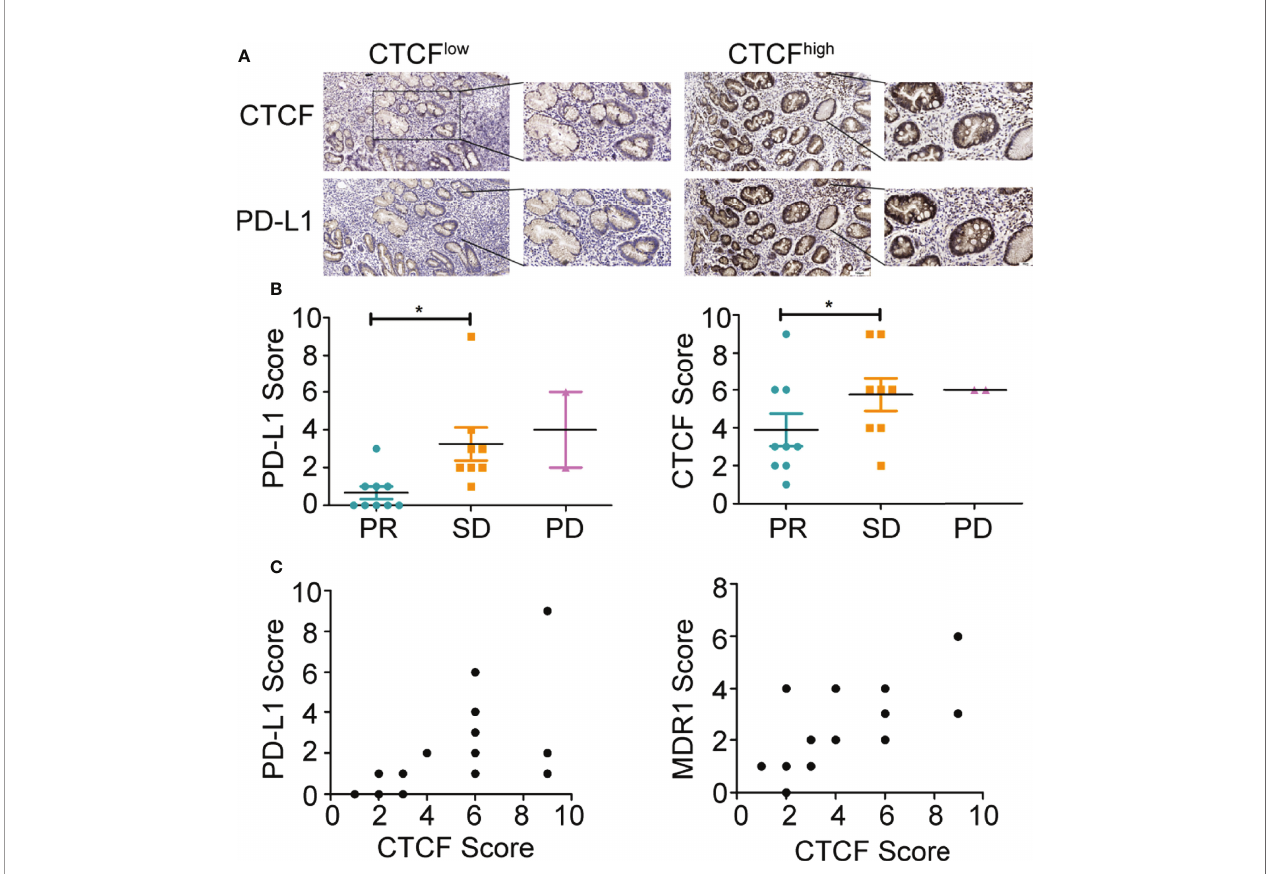
FIGURE 5 | PD-L1 and CTCF are positively correlated in clinical GC samples. (A) Representative immunohistochemical staining images of CTCF and PD-L1 in GC tissues from patients (scale bar: 100 m m, 40 m m). (B) Relationship between CTCF or PD-L1 and chemotherapy effect. (C) Relationship between CTCF and PD-L1 or MDR1 in GC tissues from patients. * p <